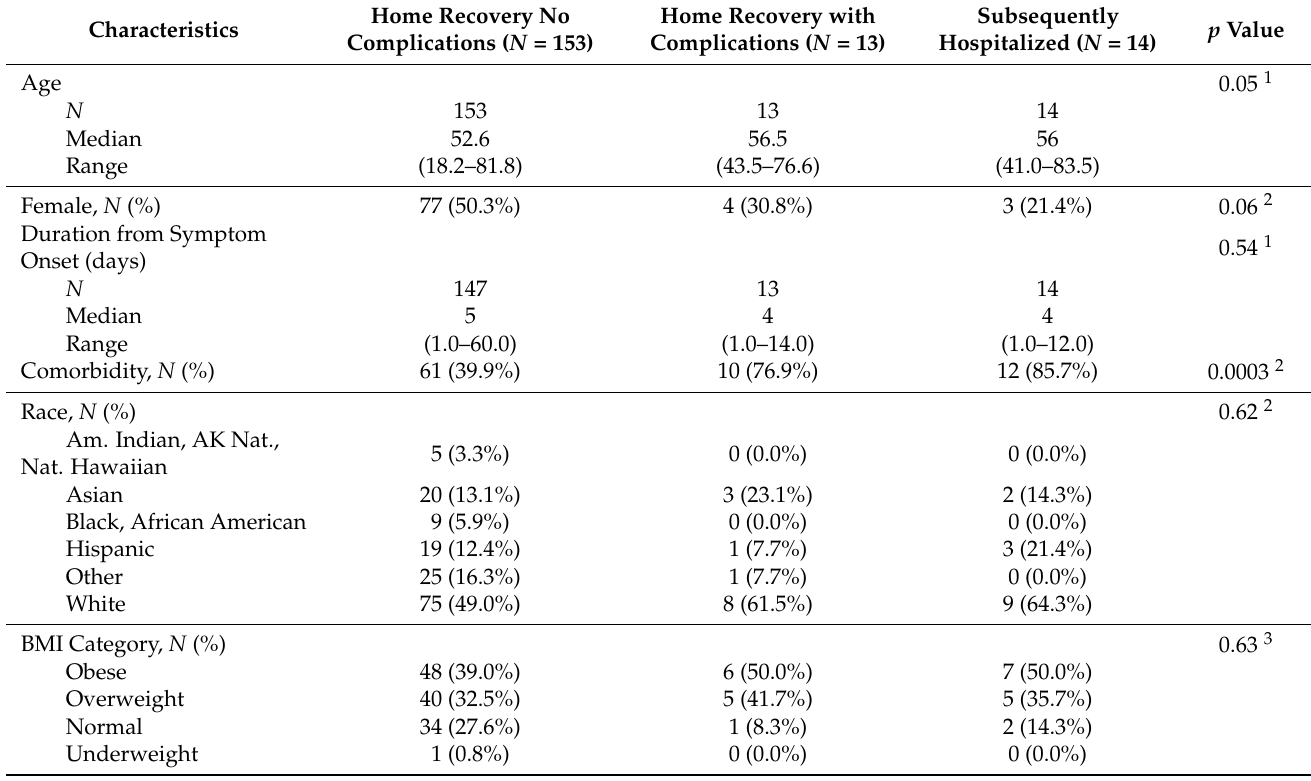
Figure 1. Patient groups based on clinical outcome. Of the 180 adult patients, 153 completed home recovery without complications (Home Recovery No Complications group), 27 experienced subsequent worsening or new symptoms after discharge with 14 of these requiring hospitalization (Subsequently Hospitalized group), and the remaining 13 completing home recovery (Home Recovery With Complications group). The Combined Home Recovery group consisted of both Home Recovery No Complications and Home Recovery With Complications ( n = 166). Table 1. Clinical Characteristics and Demographics of Patient Population based on